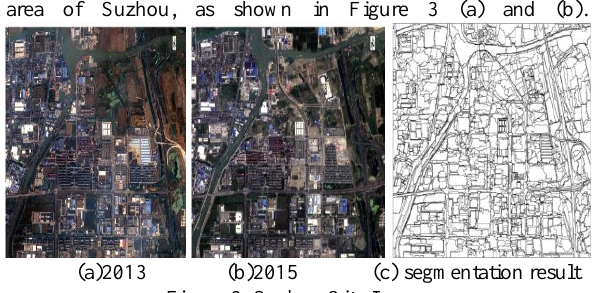
Figure 3. Suzhou City Image Figure 4. Different weight results of change